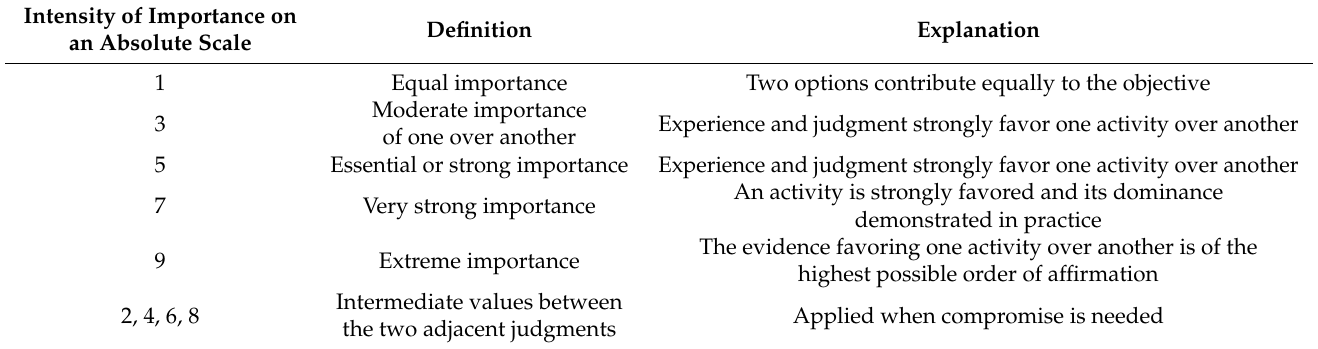
Table 1. Saaty’s fundamental scale for the AHP